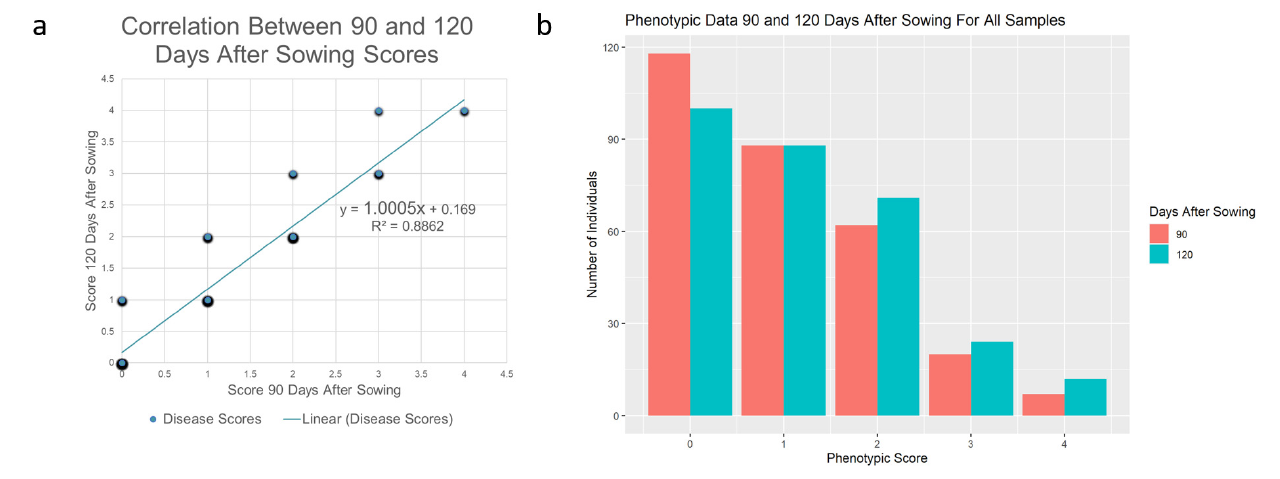
Figure 2. Summary of phenotyping for cotton leaf curl virus (CLCuV) of mapping populations. ( a ). Correlation graph between the disease ratings for CLCuV at the two time points of observation. Rating scale of 0 to 4, where 0 = no symptoms and 4 = severe curling and very reduced boll set. Size of plot points indicates the number of individuals with that given rating. ( b ) Distribution of phenotypes across all the populations at 90 and 120 days after sowing.